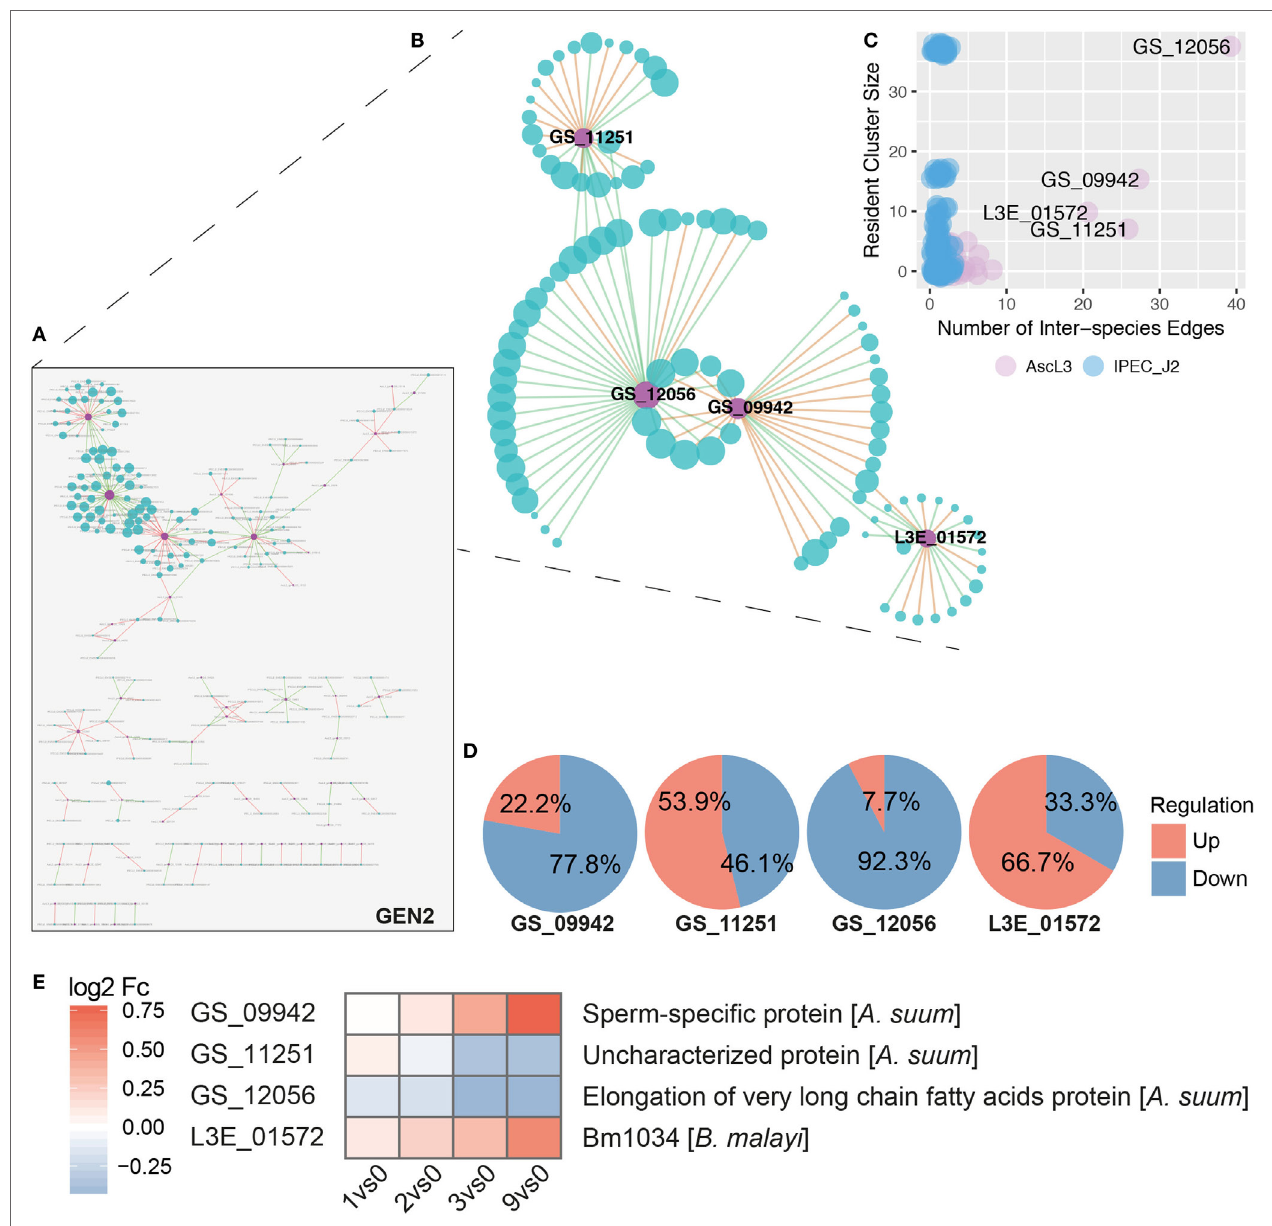
FigUre 7 | Inferred interspecies gene co-expression network. (a) Gene co-expression network reduced to interspecies nodes and interspecies edges (GEN2). Nodes represent co-expressed genes of S. scrofa (blue) and A. suum (violet) with node sizes corresponding to node degree (number of node interactions in GEN1). Edges between two nodes represent correlations that are either positive (green) or negative (red) with a Spearman correlation > 0.95. (B) The four most prominent interspecies clusters (Cluster 1, 2, 4, and 5, Table S2 in Supplementary Material) of the interspecies network GEN1 projected to GEN2 (i.e., without intra-species edges). (c) Number of interspecies edges versus cluster size for A. suum (AscL3, violet) and S. scrofa (IPEC-J2, blue) nodes [differentially expressed genes (DEGs)]. (D) Averaged gene regulation direction (based on max Fc) for all S. scrofa (IPEC-J2) DEGs connected to the four indicated A. suum (AscL3) genes. (e) Annotation and gene expression of the four interspecies network dominating A. suum genes over time by heatmapping the log2